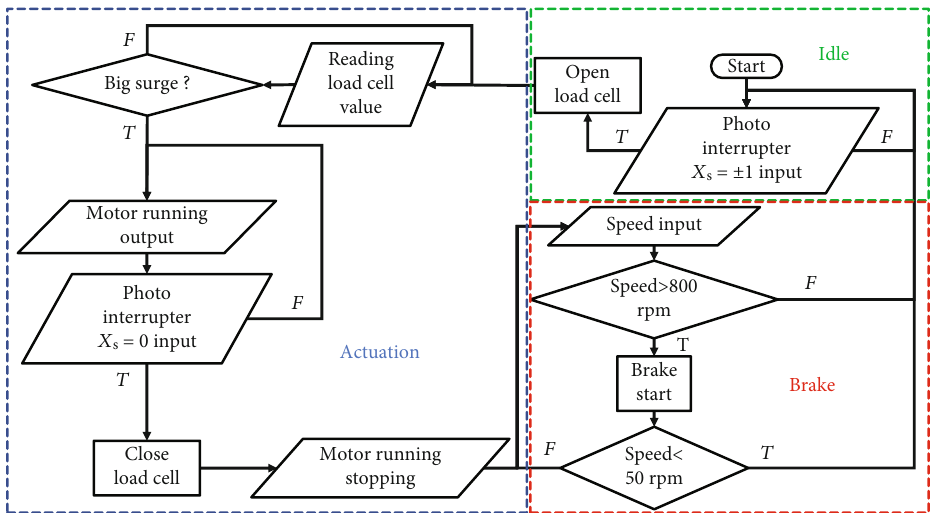
Figure 12: Flowchart of the control algorithm.